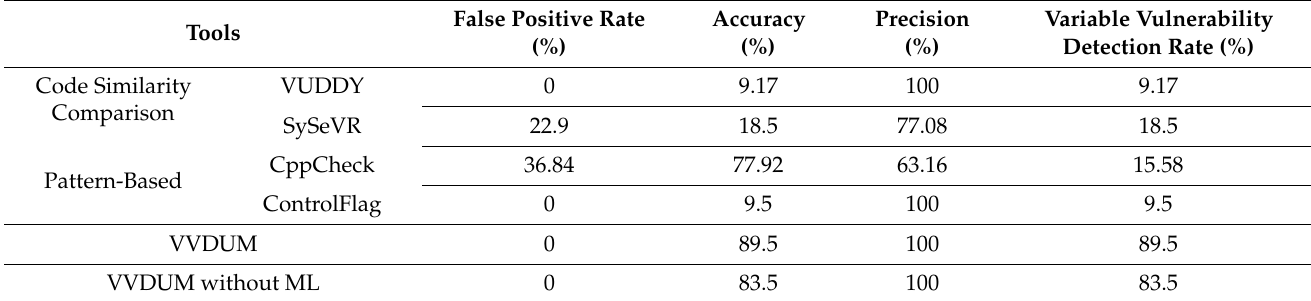
Table 5. Comparison of variable vulnerability detection results.